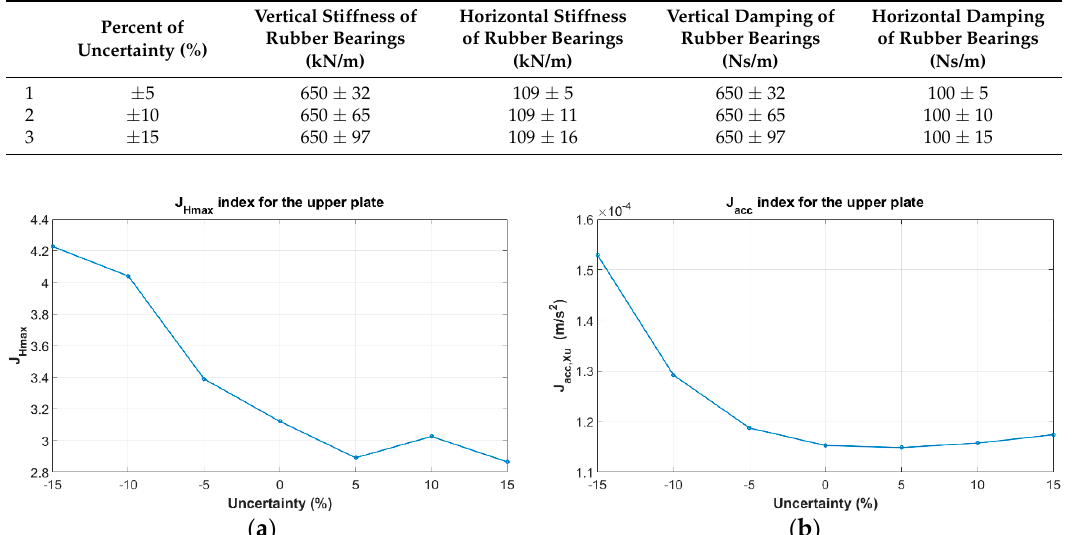
Table 5. The values of uncertainties assumed for stiffness and damping of the rubber bearings.